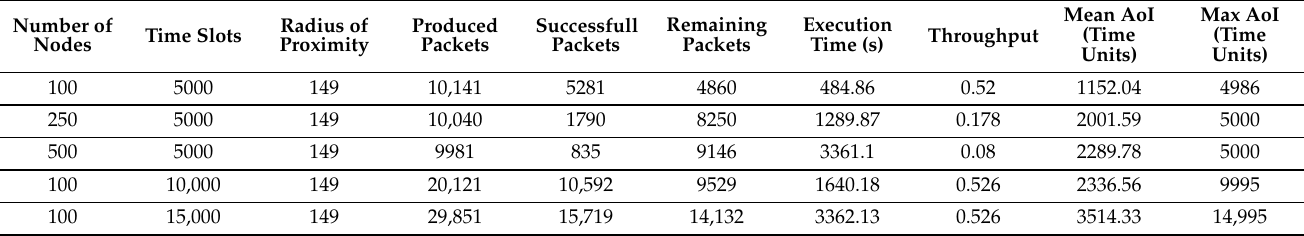
Table 12. Larger scale simulation for